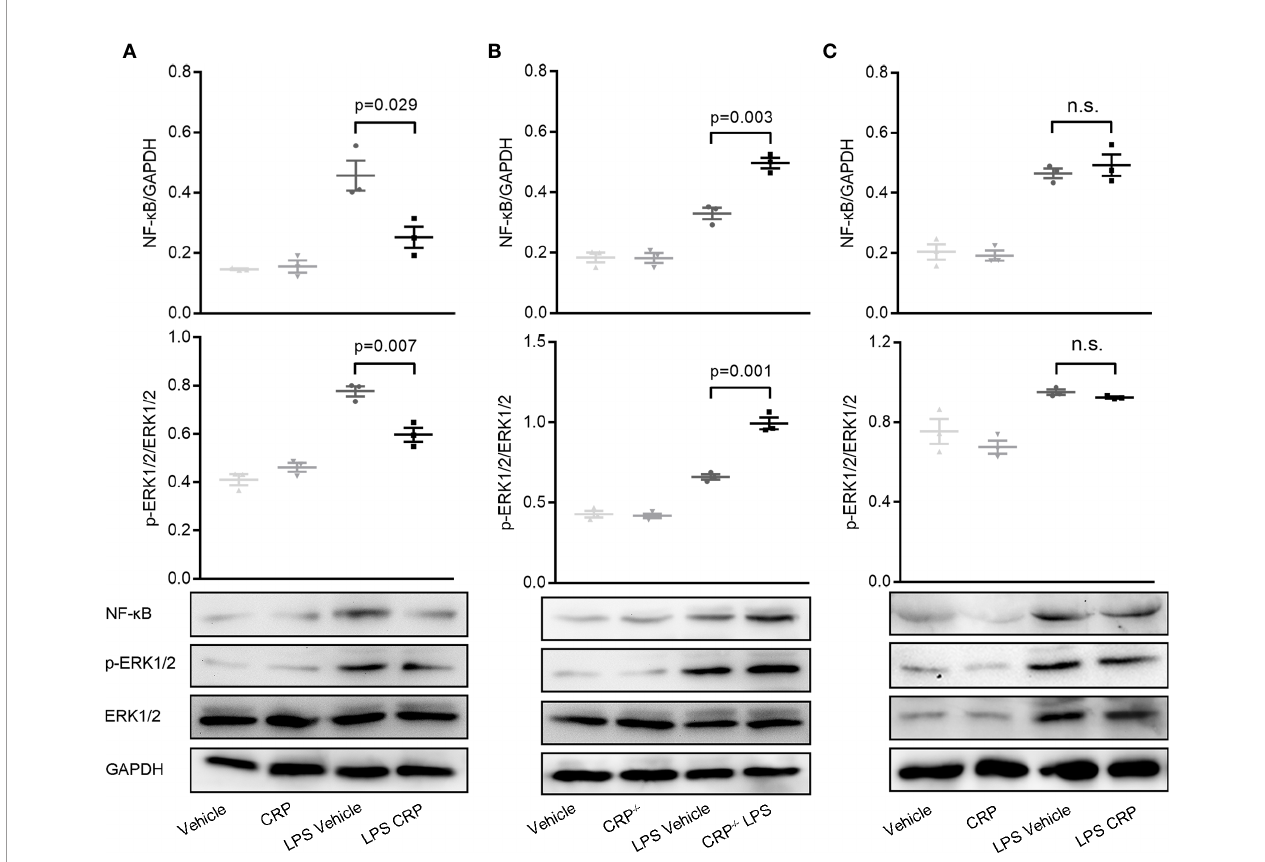
FIGURE 7 | NF- k B and ERK signaling is involved in decreasing the antigen presenting ability of moDCs by CRP. (A) Western Blot and quantitative analyses of NF- k B and p-ERK in moDCs from WT mice with or without LPS and CRP (n = 3). (B) Western Blot and quantitative analyses of NF- k B and p-ERK in moDCs from WT mice and CRP − / − mice with or without LPS and CRP (n = 3). (C) Western Blot and quantitative analyses of NF- k B and p-ERK in moDCs from Fc g R2B − / − mice with or without LPS and CRP (n = 3). Data are presented as mean ± SEM; p < 0.05 was considered statistically signi fi